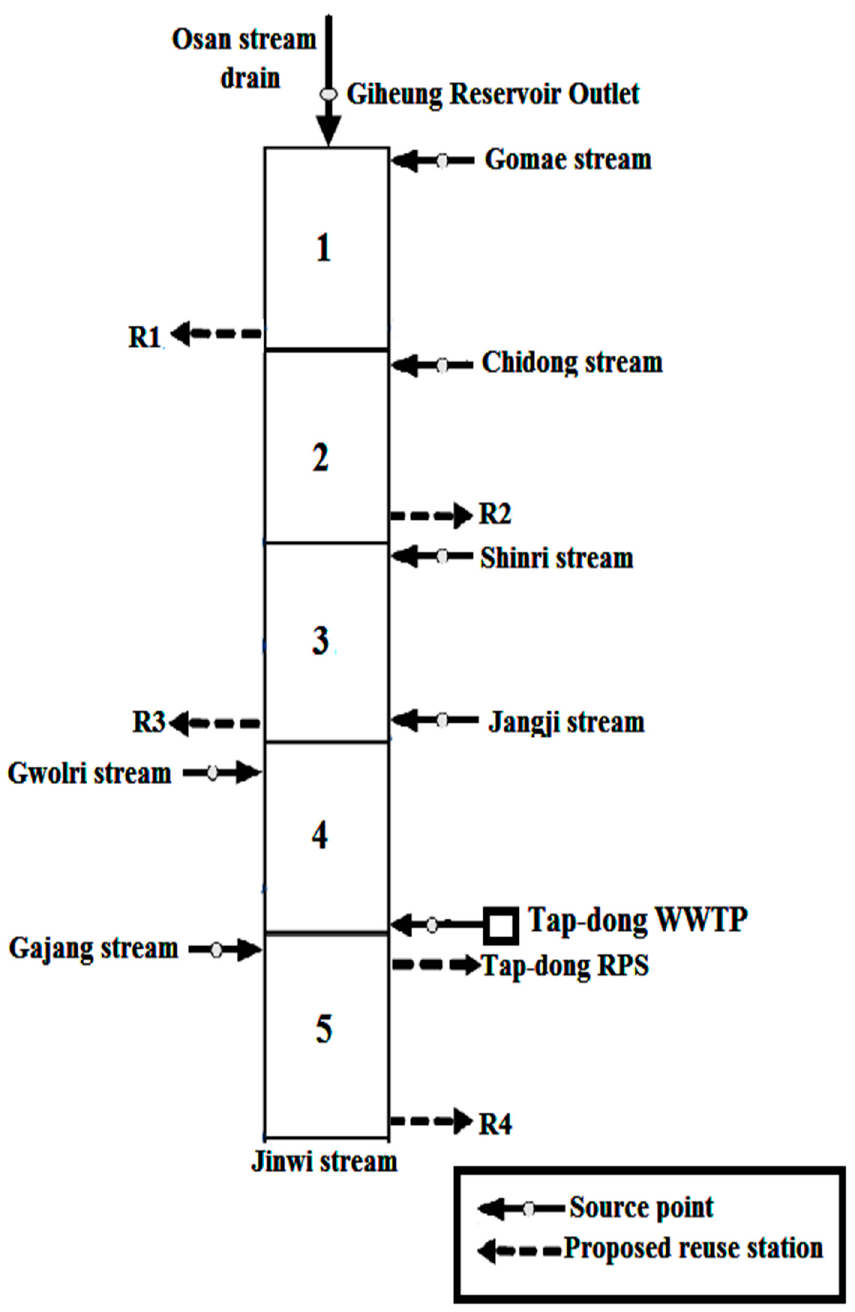
Figure 2. Discretization of Osan Stream